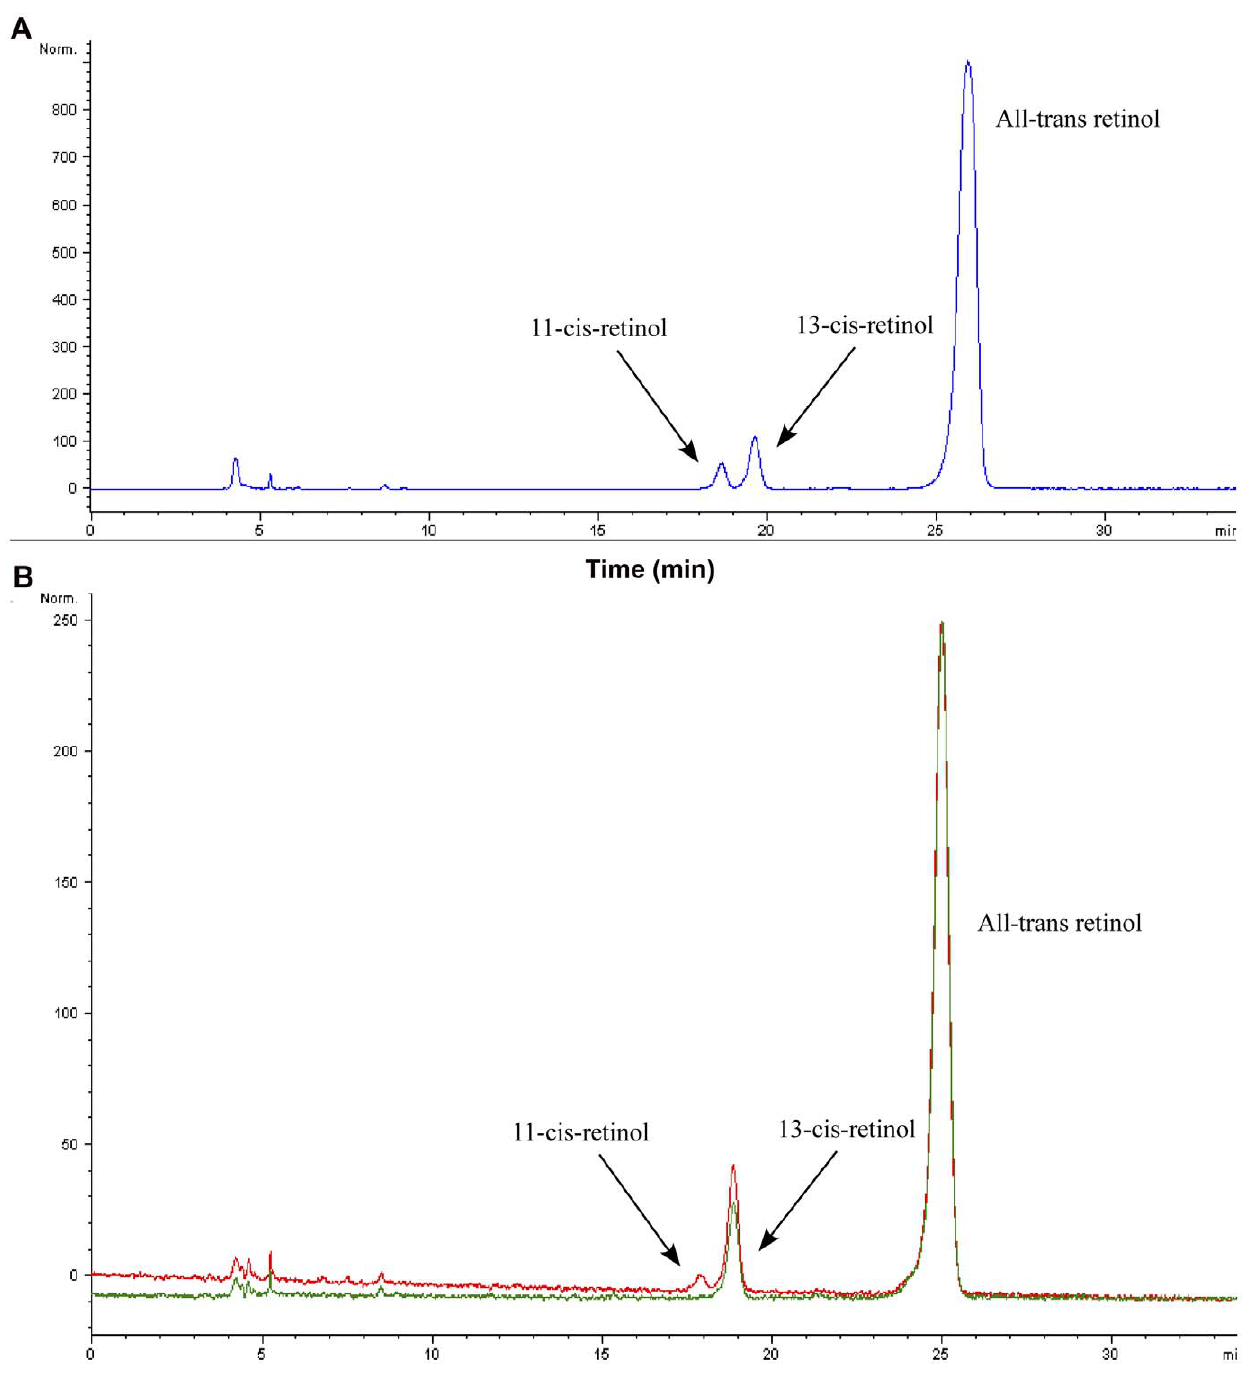
Figure 2. Production of 11- cis retinol by Lamprey RPE65 in HEK293F cells. A: Normal-phase HPLC of retinol isomers from saponified retinyl esters isolated from HEK293F cells expressing Lamprey RPE65 and bovine LRAT ( blue trace ). B: Normal-phase HPLC of retinol isomers from saponified retinyl esters isolated from HEK293F cells expressing Lamprey RPE65 with Lamprey LRAT ( red trace ) or only Lamprey LRAT ( green trace ).